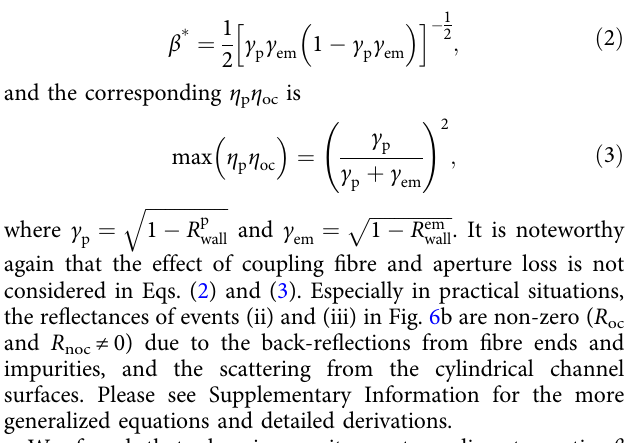
demagni fi es the propagation angles (using the numerical aperture and magni fi cation, respectively) at the image sensor plane.